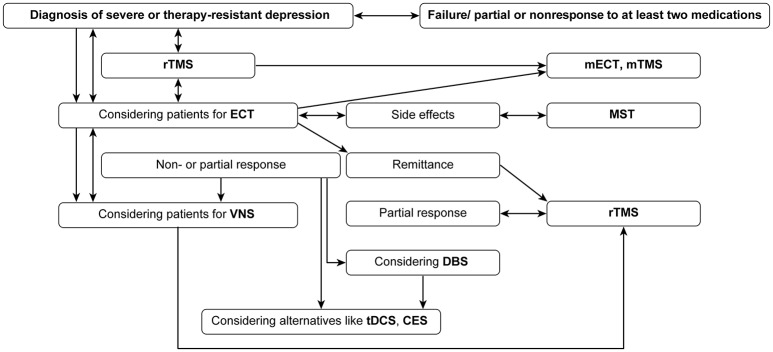
Clinical pathways when choosing neurostimulation techniques.